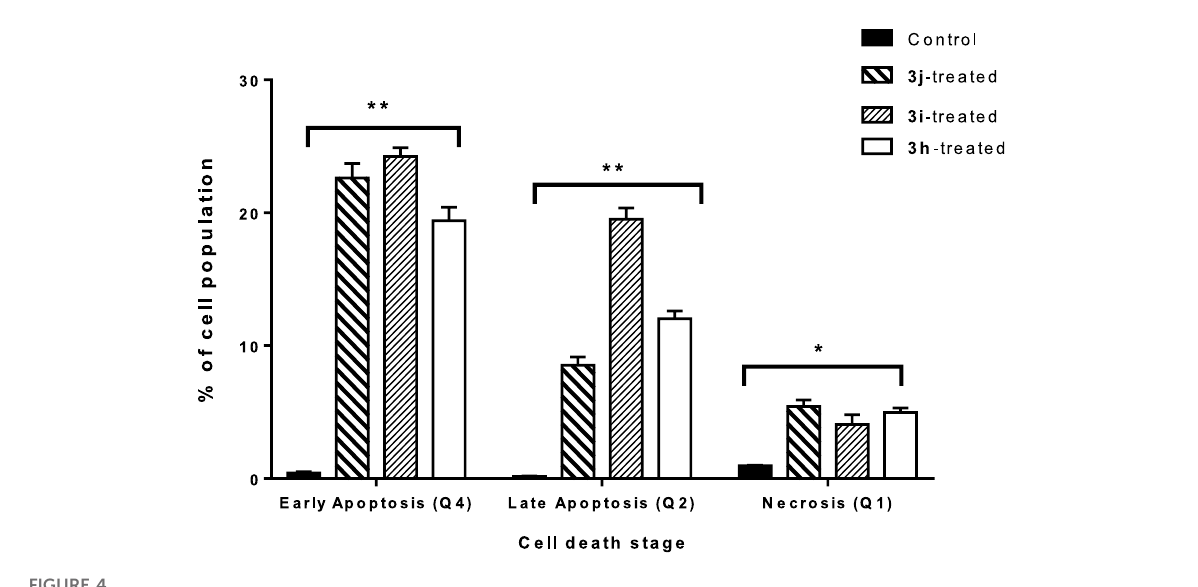
FIGURE 4 Bar representation of the percentage of early, intermediate, and late apoptotic cell population in untreated and 3j- , 3i- , and 3h- treated A549 cells, with the IC 50 value at 48 h, using Annexin V/Propidium Iodide staining “ Q1 (intermediate apoptosis, AV-/PI+), Q2 (late apoptotic cells, AV+/PI+), Q3 (normal cells, AV-/PI-), and Q4 (early apoptotic cells, AV+/PI-). Data shown are the average of three independent experimental runs (Mean ± SD).